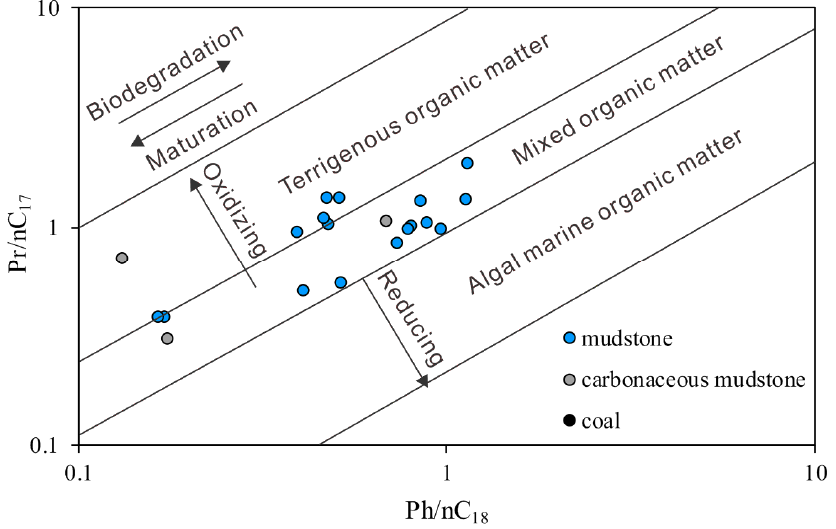
Figure 9. Cross plot of Pr/nC 17 vs. Ph/nC 18 for coal-measure source rocks (after Al-Areeq et al., 2015 [44]).